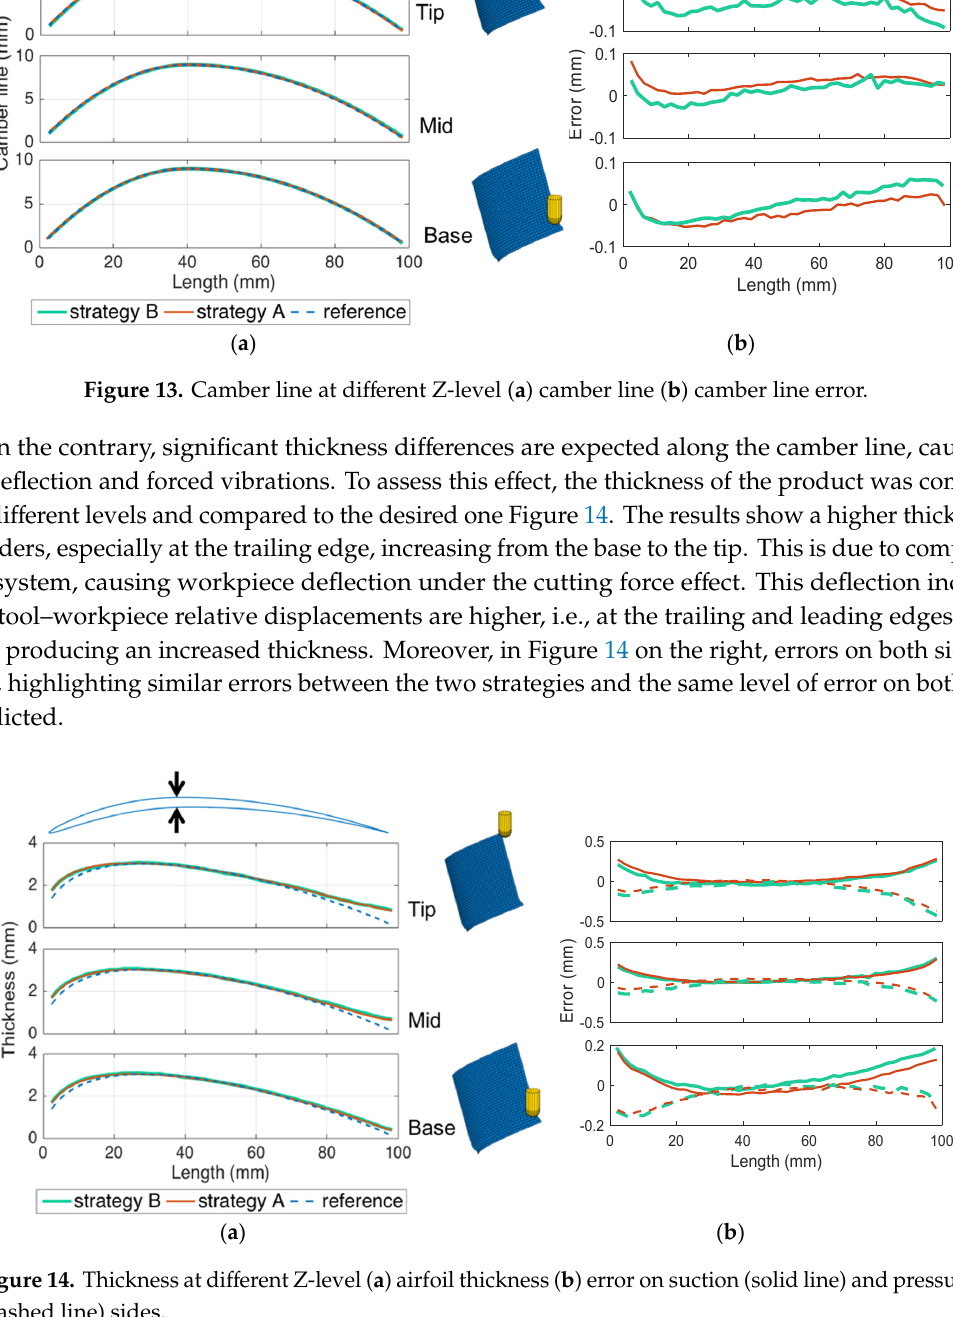
Figure 14. Thickness at different Z-level ( a ) airfoil thickness ( b ) error on suction (solid line) and pressure (dashed line) sides.